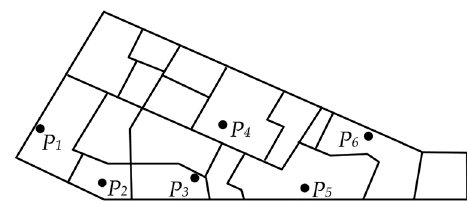
Figure 1. Original point cluster and the road network.